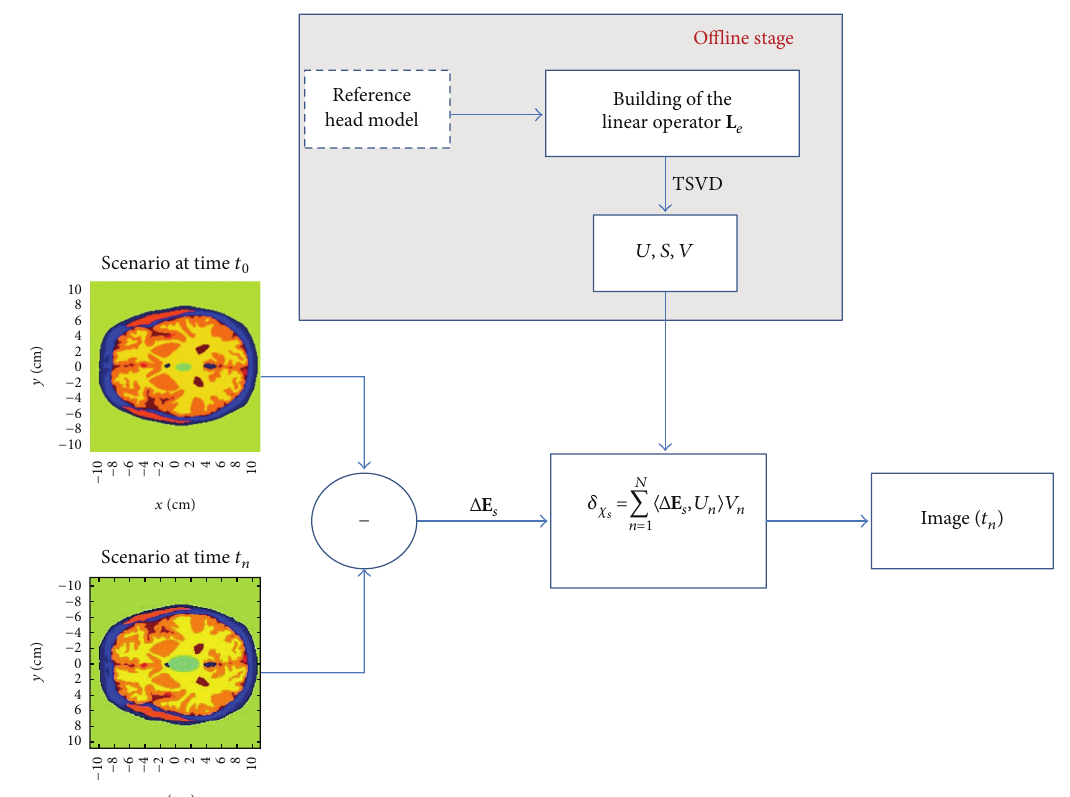
Figure 1: Flow chart of the proposed procedure for differential MWI followup of brain